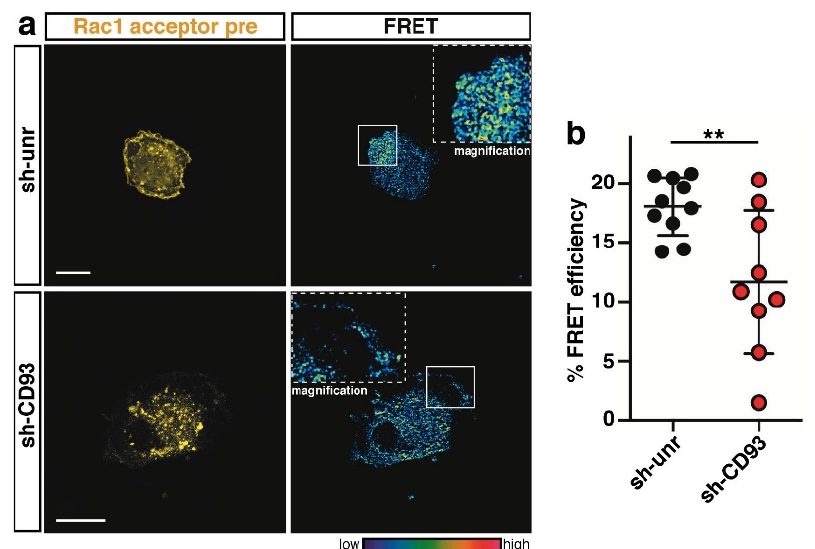
Figure 3. CD93 signaling activates Rac1 at the cell edge of spreading cells. ( a ) FRET analysis on control (sh-unr) or CD93-silenced (sh-CD93) HUVECs transduced with a lentiviral construct expressing the Rac1 biosensor. Cells were fixed at the early phase of adhesion to the ECM. Representative confocal images of transduced cells before photobleaching (acceptor pre) are shown. Rectangles indicate the photobleached cell area. Magnifications of the photobleached area are shown (2.5 × ). The colored scale represents the color range of FRET efficiency. Scale bars, 20 µ m. ( b ) Plot showing the fluorescence increase (% FRET efficiency) upon photobleaching at the cell edge of early spreading ECs ( n = 10 cells for sh-unr and n = 9 cells for sh-CD93). Data are presented as scatter plot. ** p < 0.01; Student t -test.